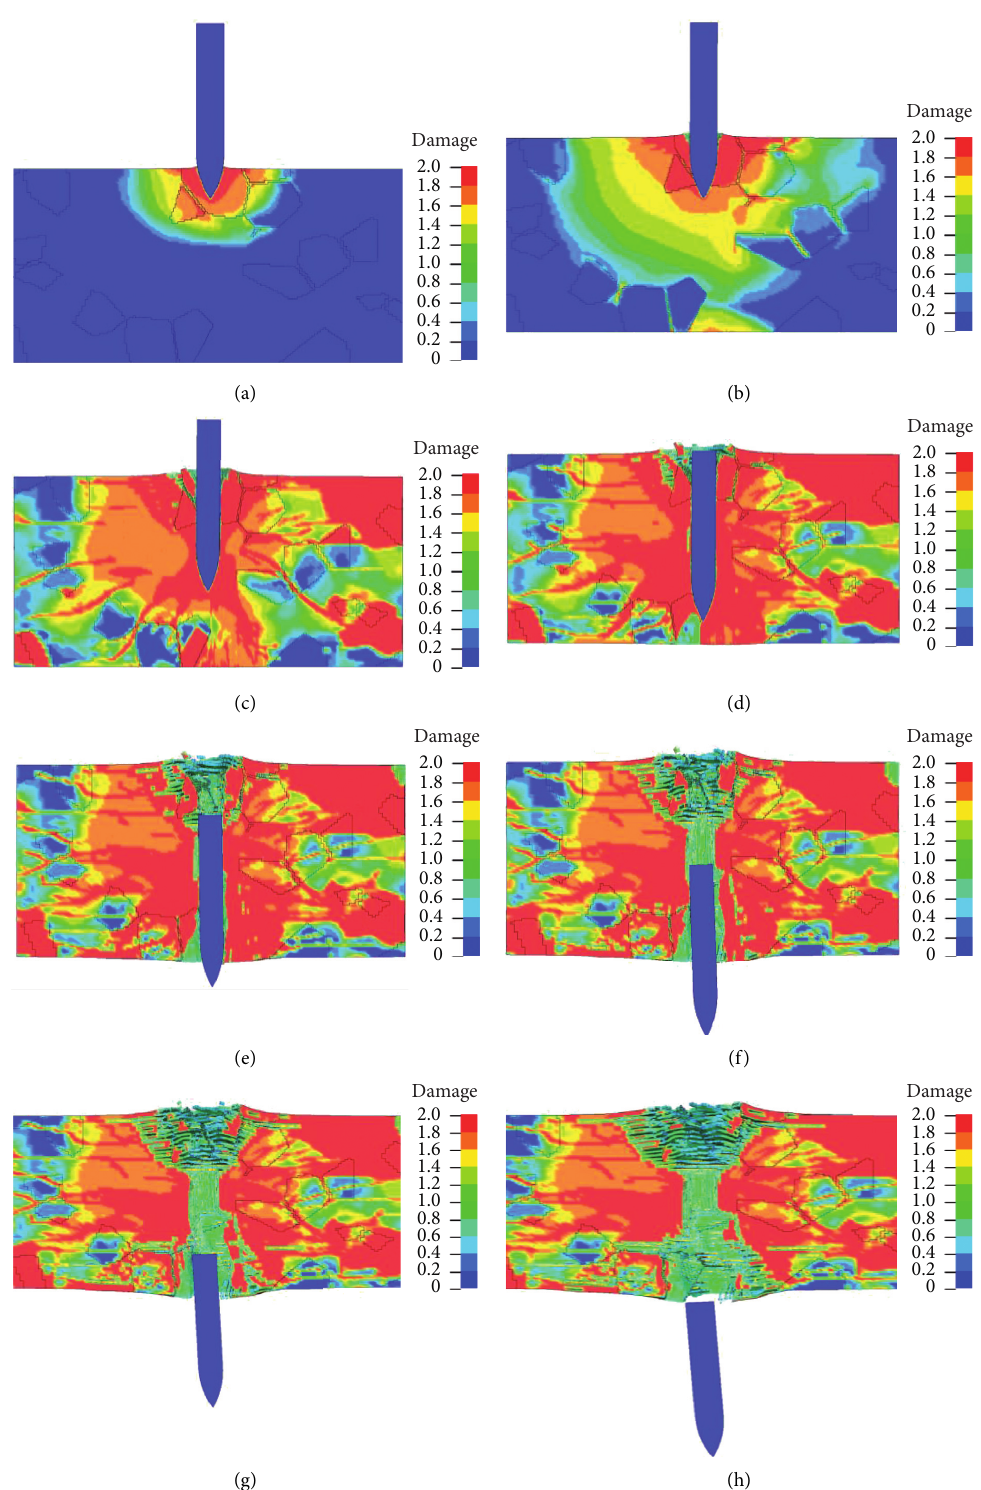
Figure 5: Simulation results of penetration into finite-thickness stone concrete. (a) t � 100 μ s. (b) t � 200 μ s. (c) t � 300 μ s. (d) t � 400 μ s. (e) t � 500 μ s. (f) t � 600 μ s. (g) t � 700 μ s. (h) t � 800 μ